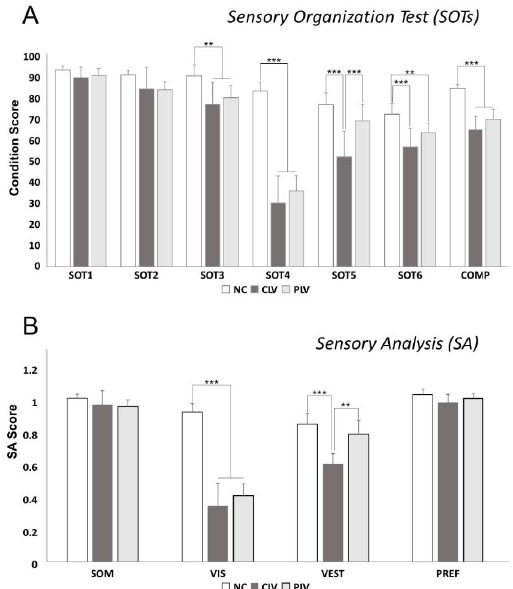
Figure 3. Sensory Organization Test (SOT) and Sensory Analysis (SA) scores: ( A ) Graphs show values